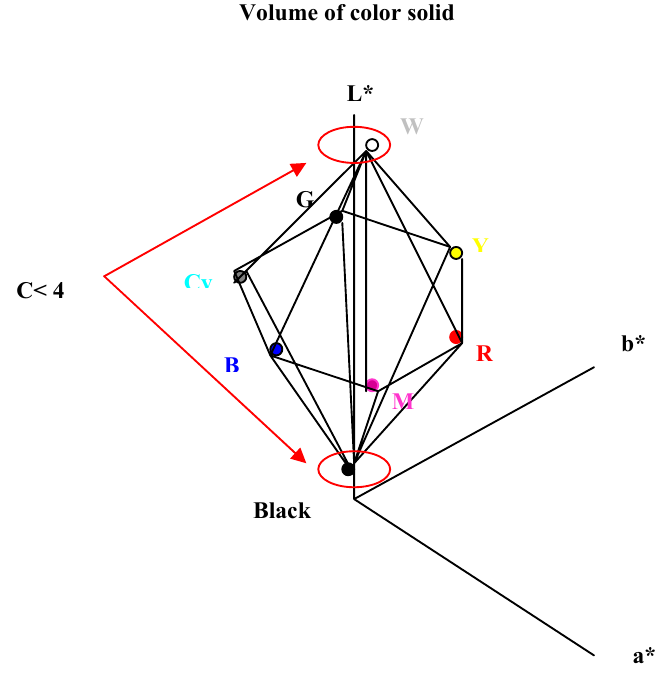
Figure 18. The color reproduction area of the three-layer